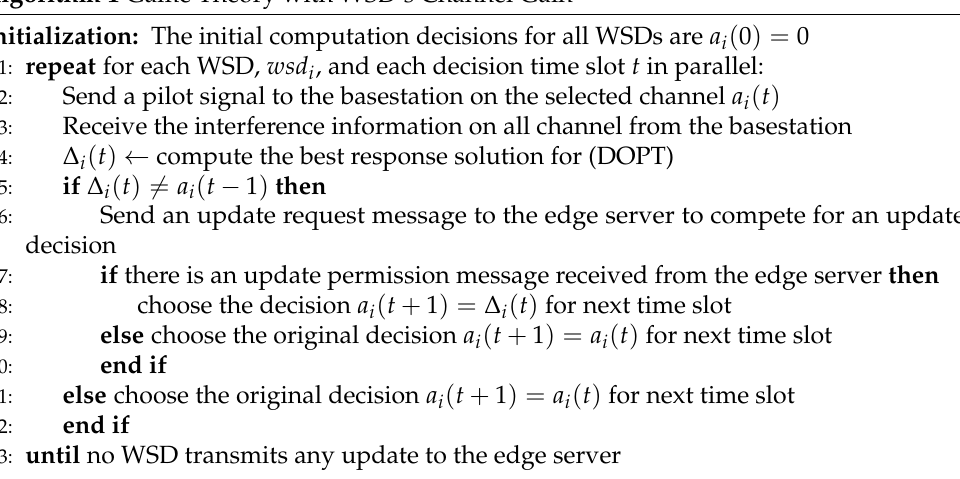
Algorithm 1 Game Theory with WSD’s Channel